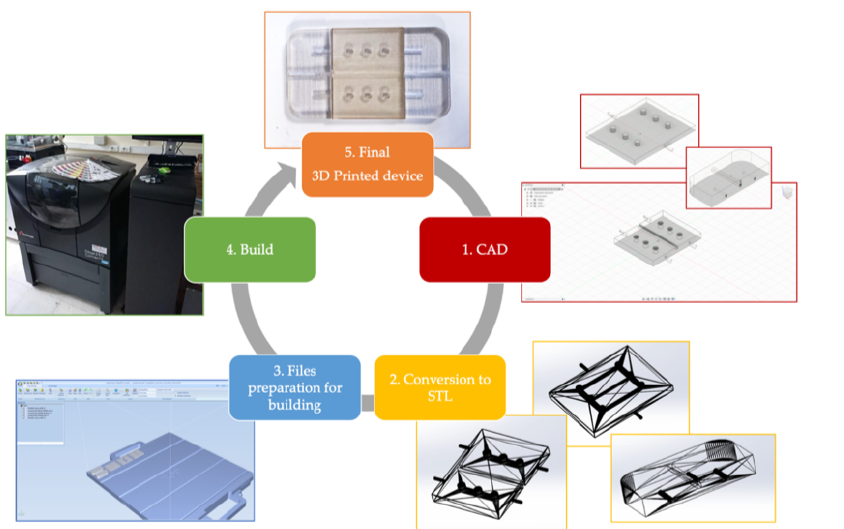
Figure 2. Additive Manufacturing (AM) process steps followed to obtain the physical final device. STL files are provided in the Supplementary